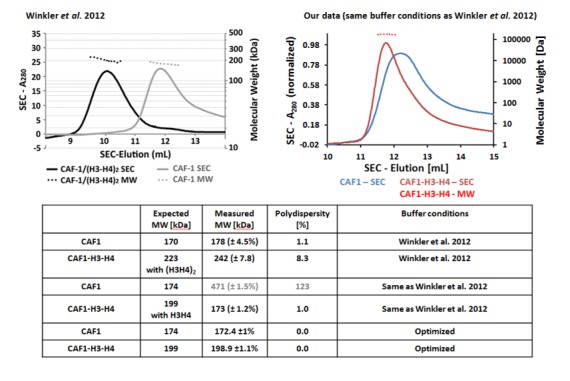
DOI:
http://dx.doi.org/10.7554/eLife.23474.023